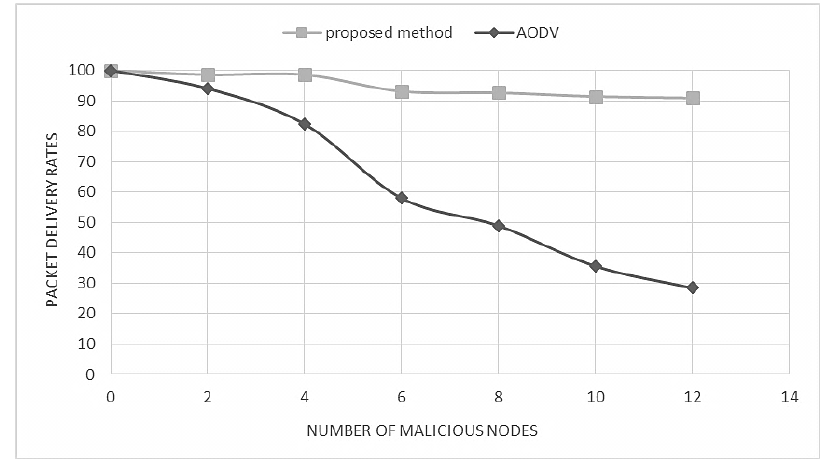
Figure 1. Packet delivery rates vs. number of malicious